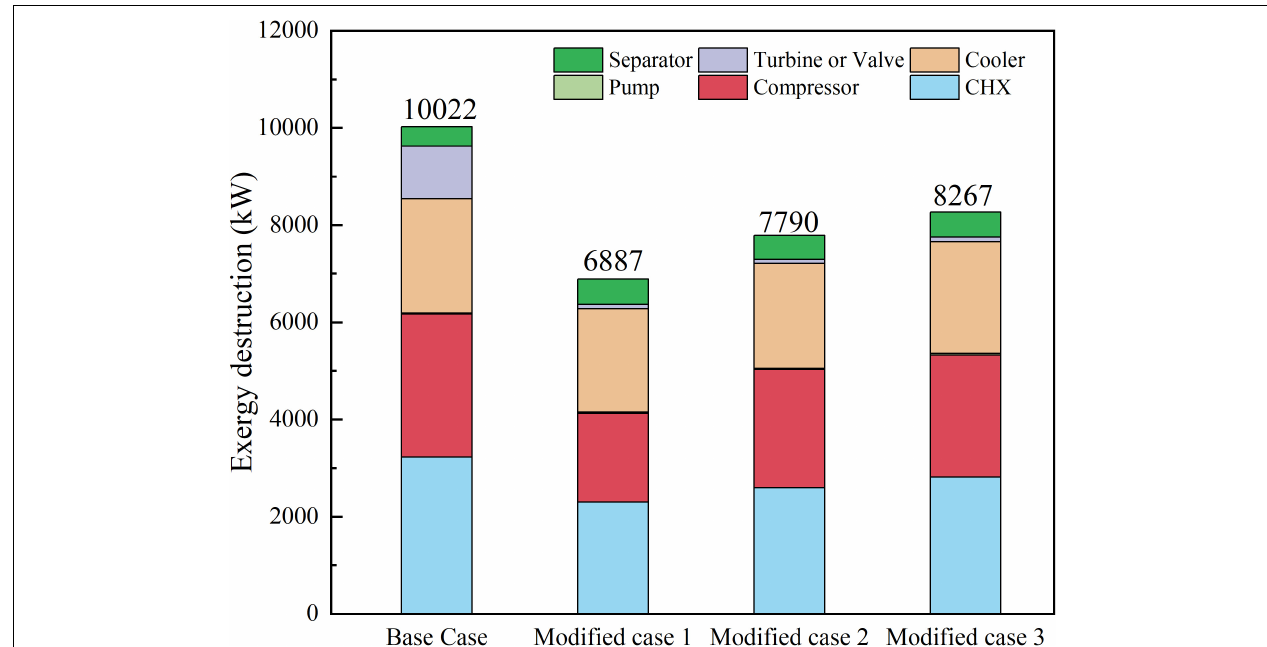
FIGURE 8 | The total exergy destruction of four cases.